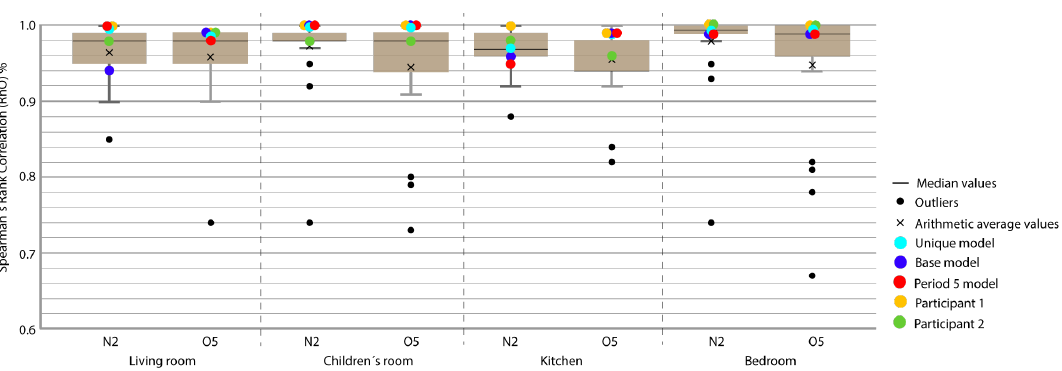
Figure 13. Temperature MAE for Period 5 (free oscillation).